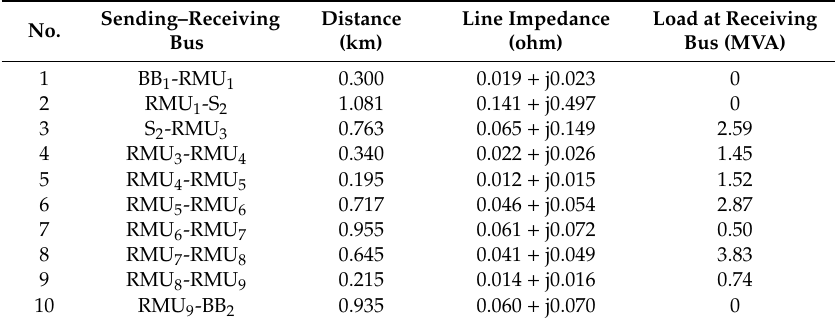
Figure 8. The topology of the distribution network and the communication network. Table 1. Parameters of distribution network.